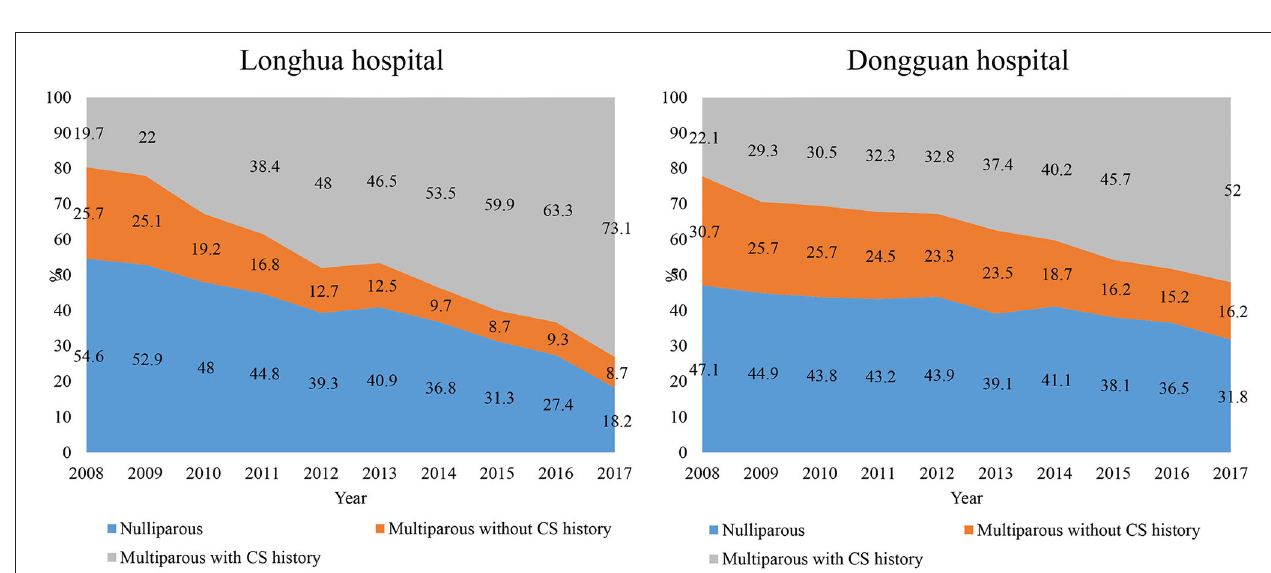
FIGURE 3 | Comparison between Longhua and Dongguan hospitals on trends in CS rate in 10 years from 2008 to 2017, by Robson classification. Robson’ class 1: Nulliparous, single, cephalic, ≥ 37 weeks; Robson’s class 2: Multiparous, single, cephalic, ≥ 37 weeks, without uterine scar; Robson’s class 3: Uterine scar, single, cephalic, ≥ 37 weeks; Robson’s class 4–7 (Nulliparous, single, breech/multiparous, single, breech/all multiple pregnancies/all single other abnormal lies; Robson’s class 8: All single, cephalic, ≤ 36 weeks.